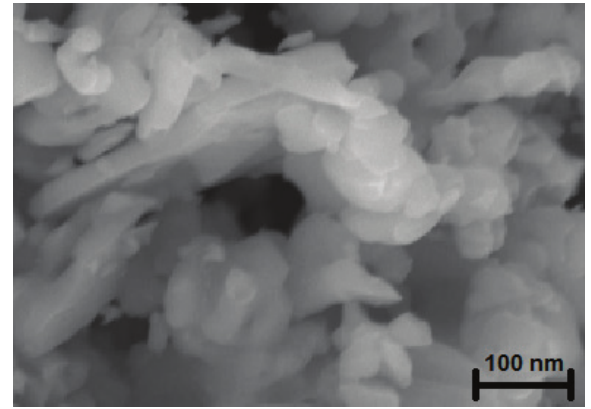
O reinforcement particles. 2 3 O reinforcement 2 3